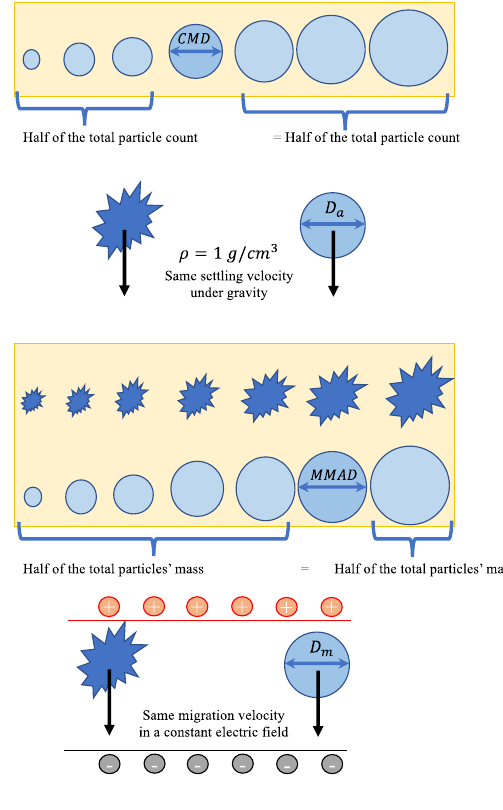
Figure 1. Illustration of particle size descriptive parameters.